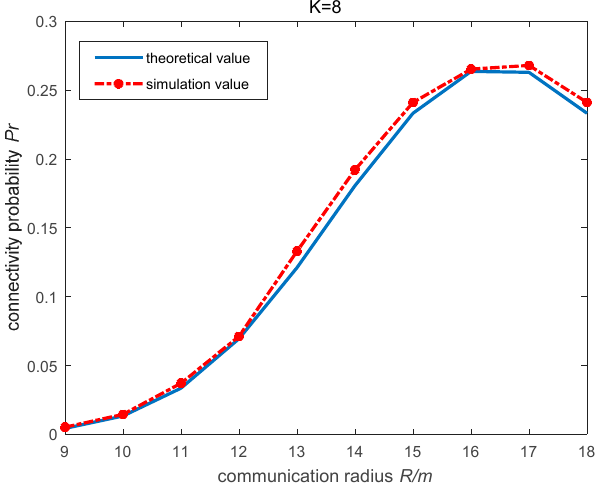
Figure 4. The relationship between the node communication radius and the connected probability diagram P r when the K = 8.